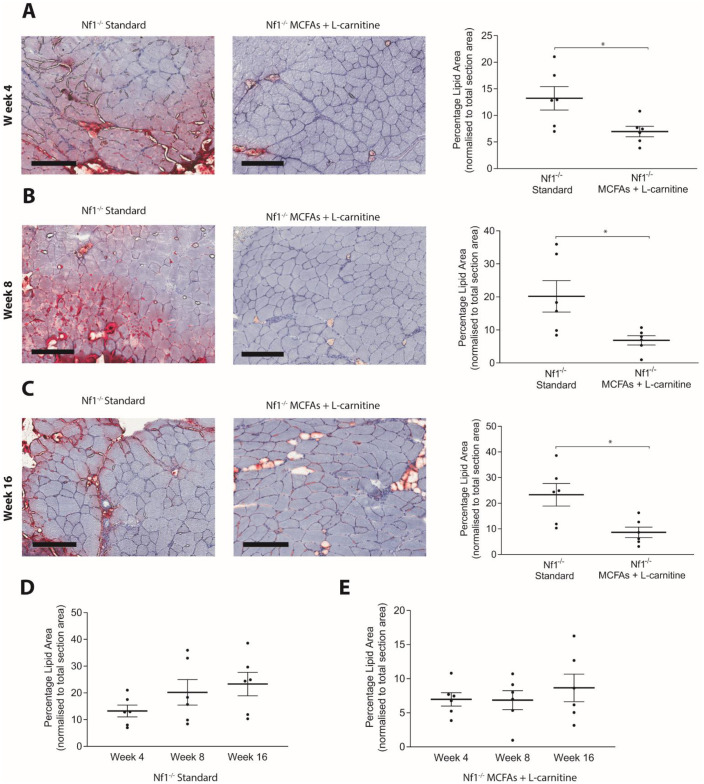
Nf1Prx1-/- mice fed MCFA + L-carnitine chow show reduced IMCL accumulation within 4 weeks of treatment.A significant reduction of IMCL accumulation was observed in quadriceps muscle of Nf1Prx1-/- mice fed MCFA + L-carnitine chow compared to standard chow fed Nf1Prx1-/- mice at all time points; (A) 4 weeks (B) 8 weeks and (C) 16 weeks of treatment. (D) IMCL accumulation did not significantly increase over 12 weeks in standard chow fed Nf1Prx1-/- mice. (E) IMCL reduction plateaued after 4 weeks of MCFA + L-carnitine treatment in Nf1Prx1-/- mice. Scale bar; 200um at 10x magnification, n = 6. Data presented as group mean ± SEM. p-values were assessed by one way ANOVA.